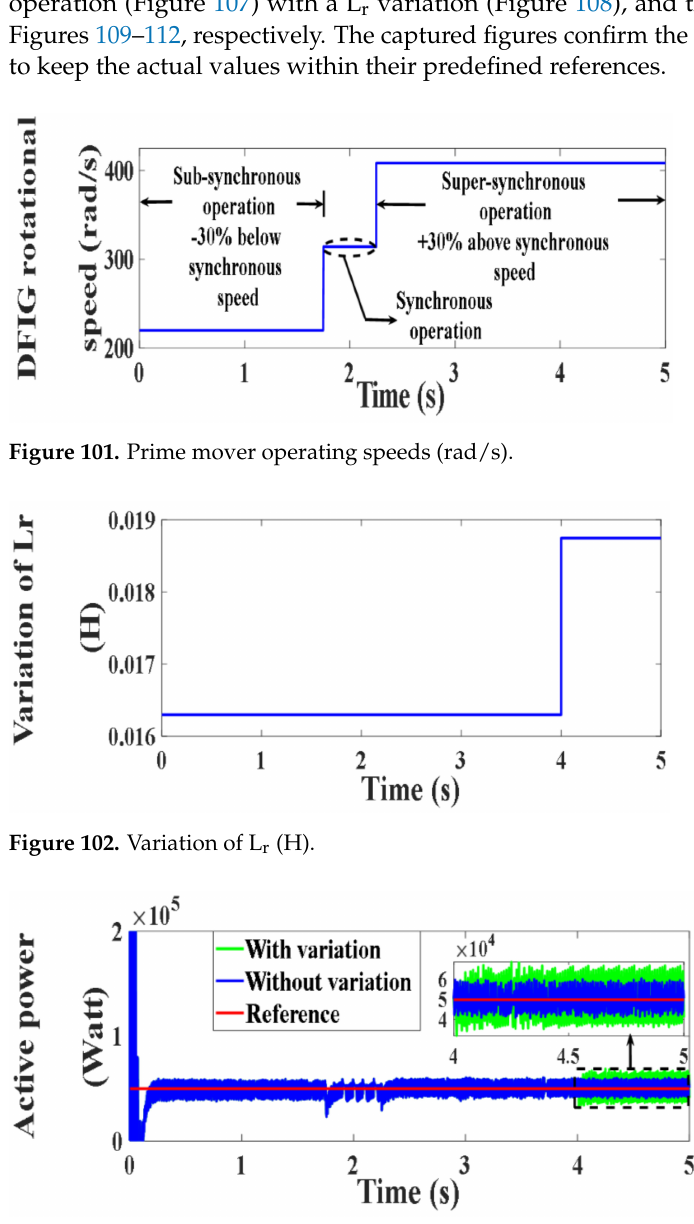
Figure 103. Active power under PVC (Watt).